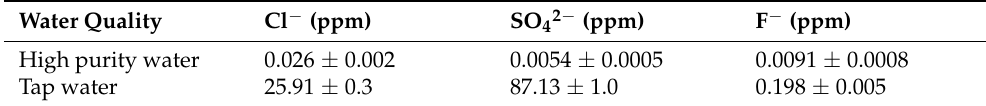
Table 3. Analysis of water quality in different environments.